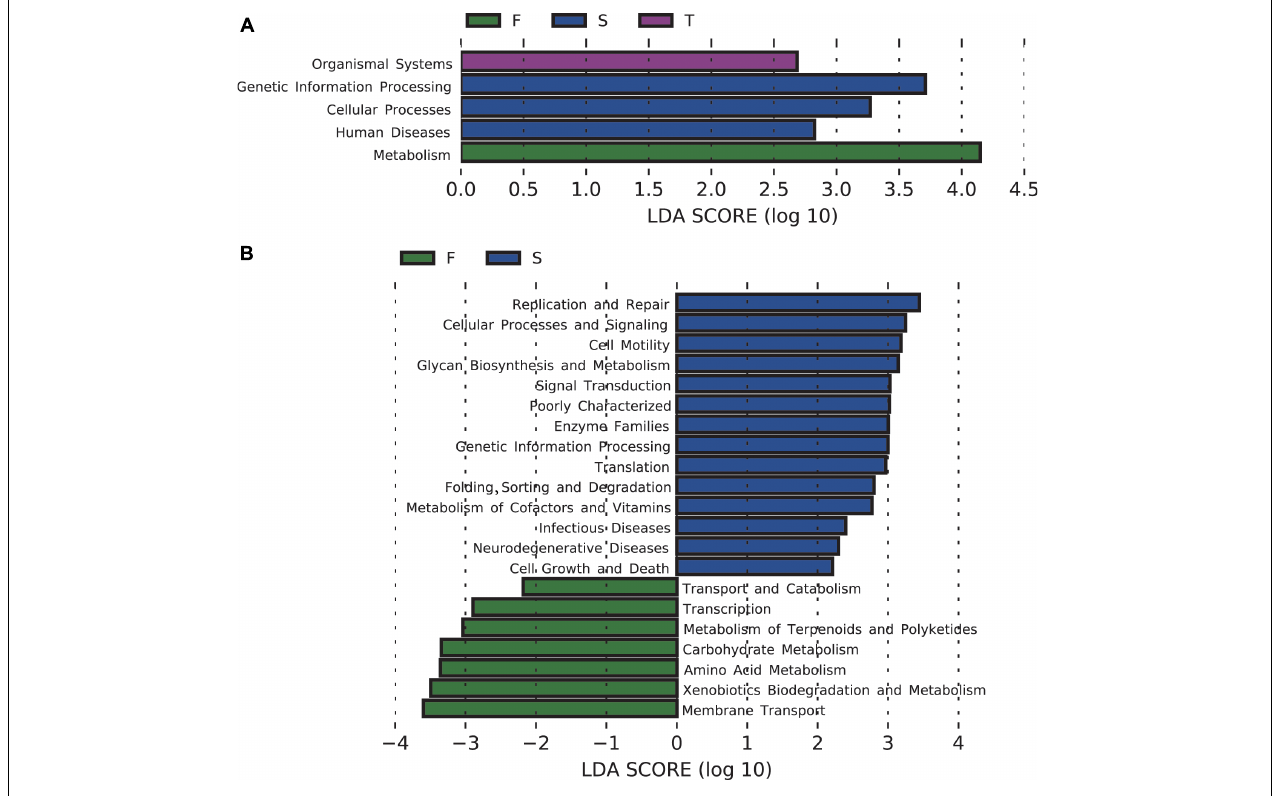
FIGURE 4 | Changes in soil bacterial community functional profiles. Histograms (A,B) showed the LDA scores calculated for the differentially abundant biomarkers at KEGG level 1 and 2, respectively ( P < 0.05). W represents the wheat field; F, S, and T represent the first, second, and third cropping of Jerusalem artichoke (JA),